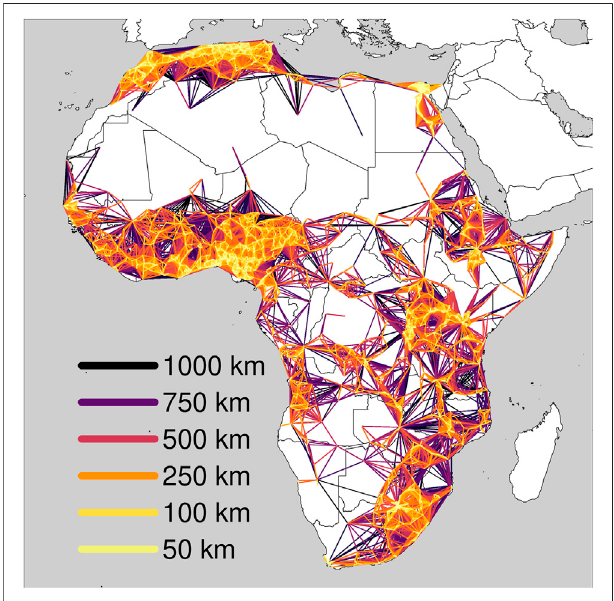
FIGURE 2 | For different values of δ , distinct regions of in fl uence are constructed. For some value of δ , all regions of in fl uence are identi fi ed using the same colour. Larger values of δ have darker colours and smaller values of δ , corresponding to smaller regions of in fl uence, have lighter